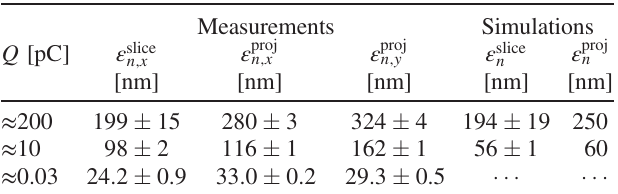
TABLE II. Measured and simulated core slice and projected emittances for different bunch charges. Measurement errors are statistical (see text for details).